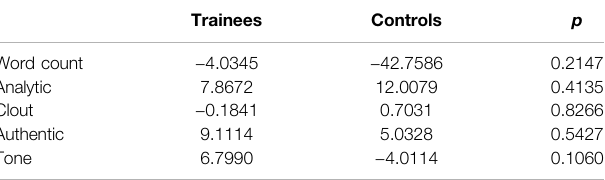
TABLE 2 | Change in trainees ’ LIWC scores (After scores minus Before scores) compared to change in control